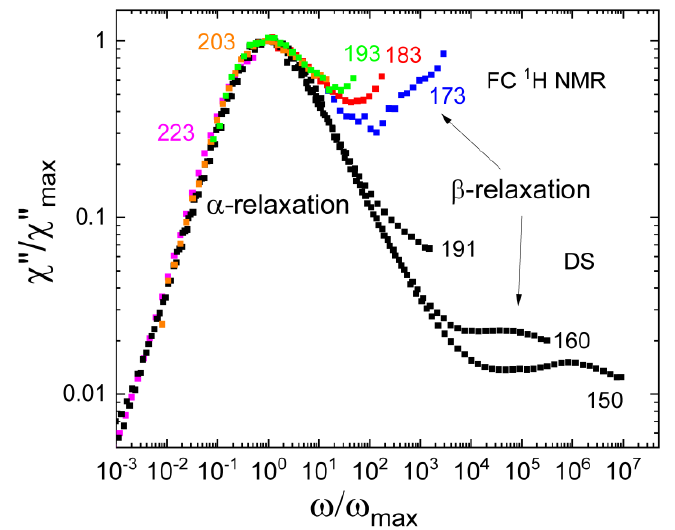
Figure 14. Susceptibility master curve of cyanocyclohexane from FC 1 H NMR relaxometry together with dielectric spectra (black symbols) at the indicated temperatures in K [145]. The data are scaled for the best overlap of the α - relaxation peak. The FC and DS data show a secondary (β -) relaxation at high frequencies. However, the amplitude of the β - relaxation with respect to that of the α -relaxation is significantly higher in FC than in DS.